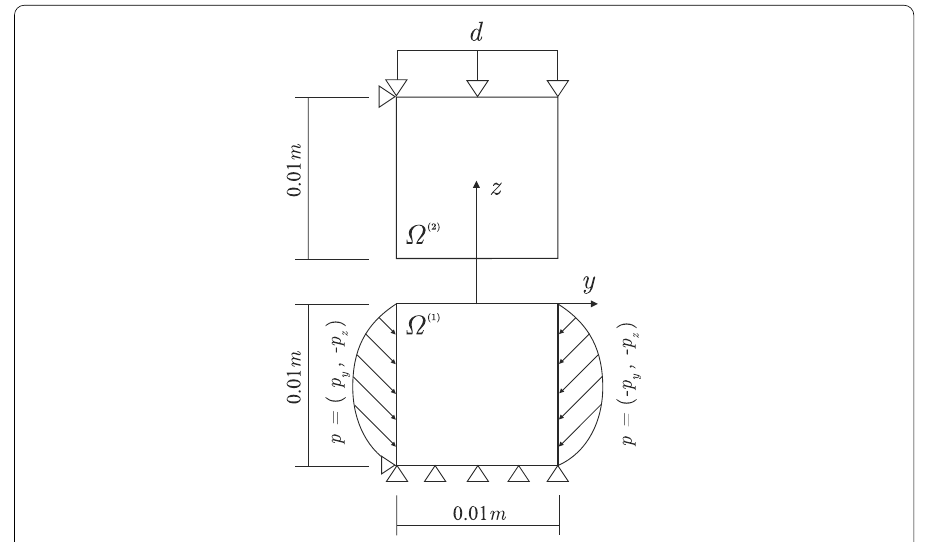
Fig. 7 Example 1. Contact between plane surfaces. Sketch of